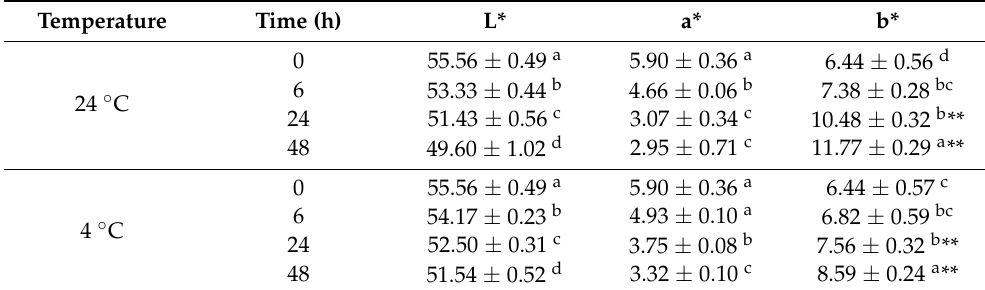
Table 2. Color of American shad meat during storage at different temperatures (i.e., unrefrigerated and refrigerated).